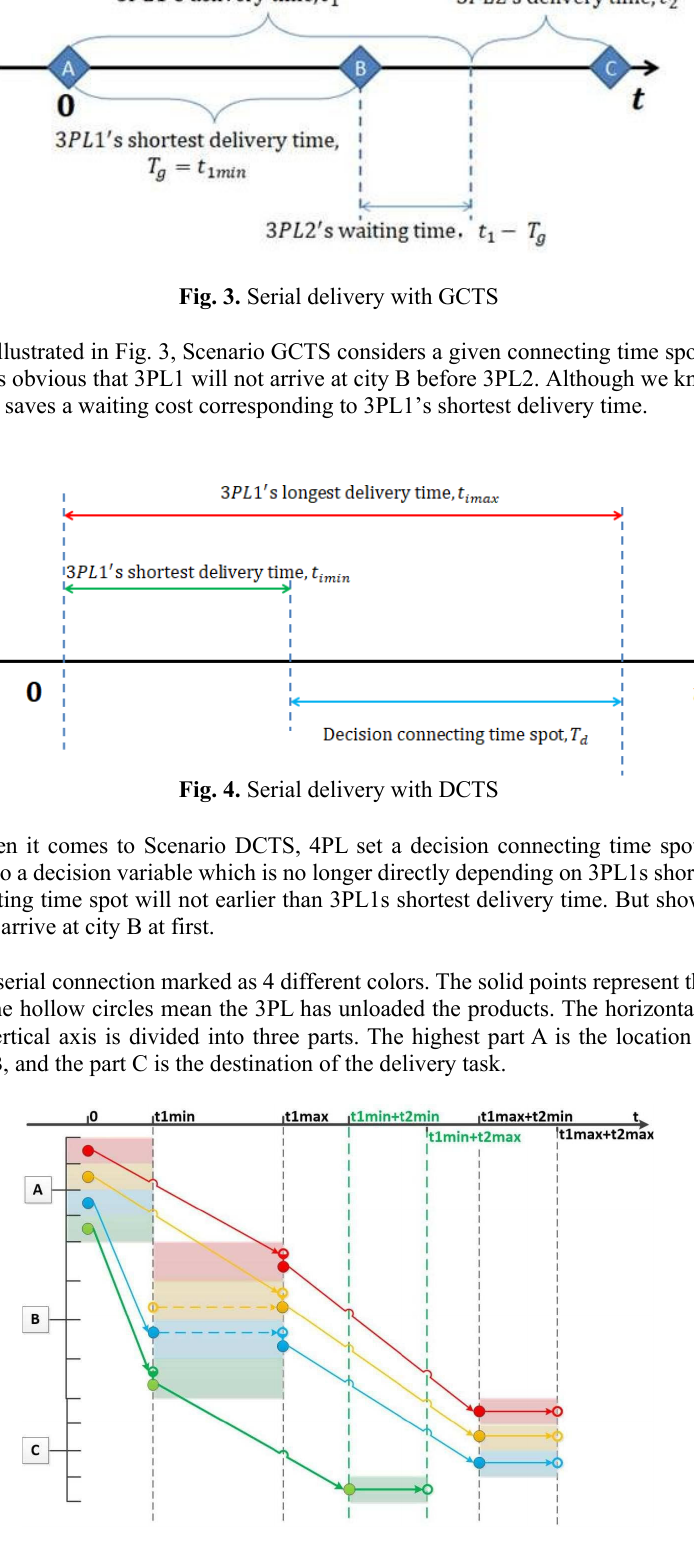
Fig. 5. Four kinds connection of serial